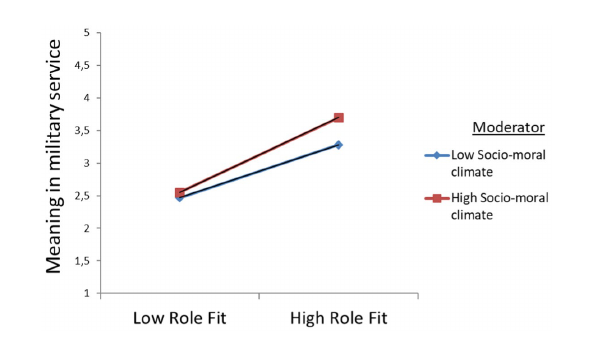
FIGURE 7 Graphical visualization of interactive effects for role fit and socio-moral climate on meaning in military service at the end of military training